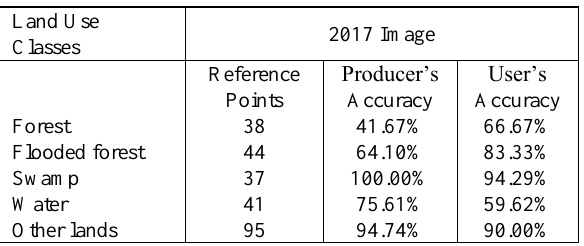
Table 4. The results of accuracy assessment based on classification of